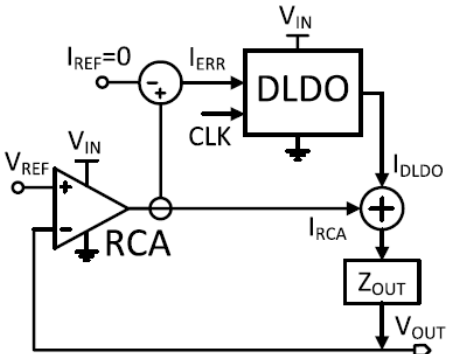
Figure 34. Active Ripple Suppression-based HD-LDO [61].